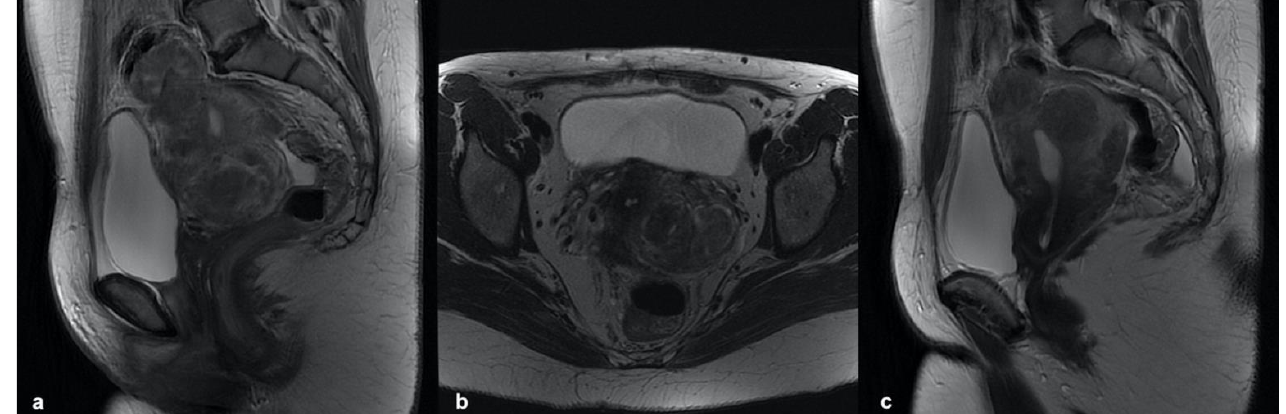
Figure 6. A 41-year-old woman affected by a different subtype of adenomyosis: ( a ) sagittal T2- weighted image showing anterior external adenomyosis with deep endometriosis of the sigma wall and a heterogeneous hypointense mass with well-defined borders, localized on the left wall of the uterine cervix (( b ), axial T2) representing a subserosal leiomyoma. ( c ) Sagittal T2-weighted image showing an intramural solid adenomyoma of the posterior wall and posterior external adenomyo- sis.